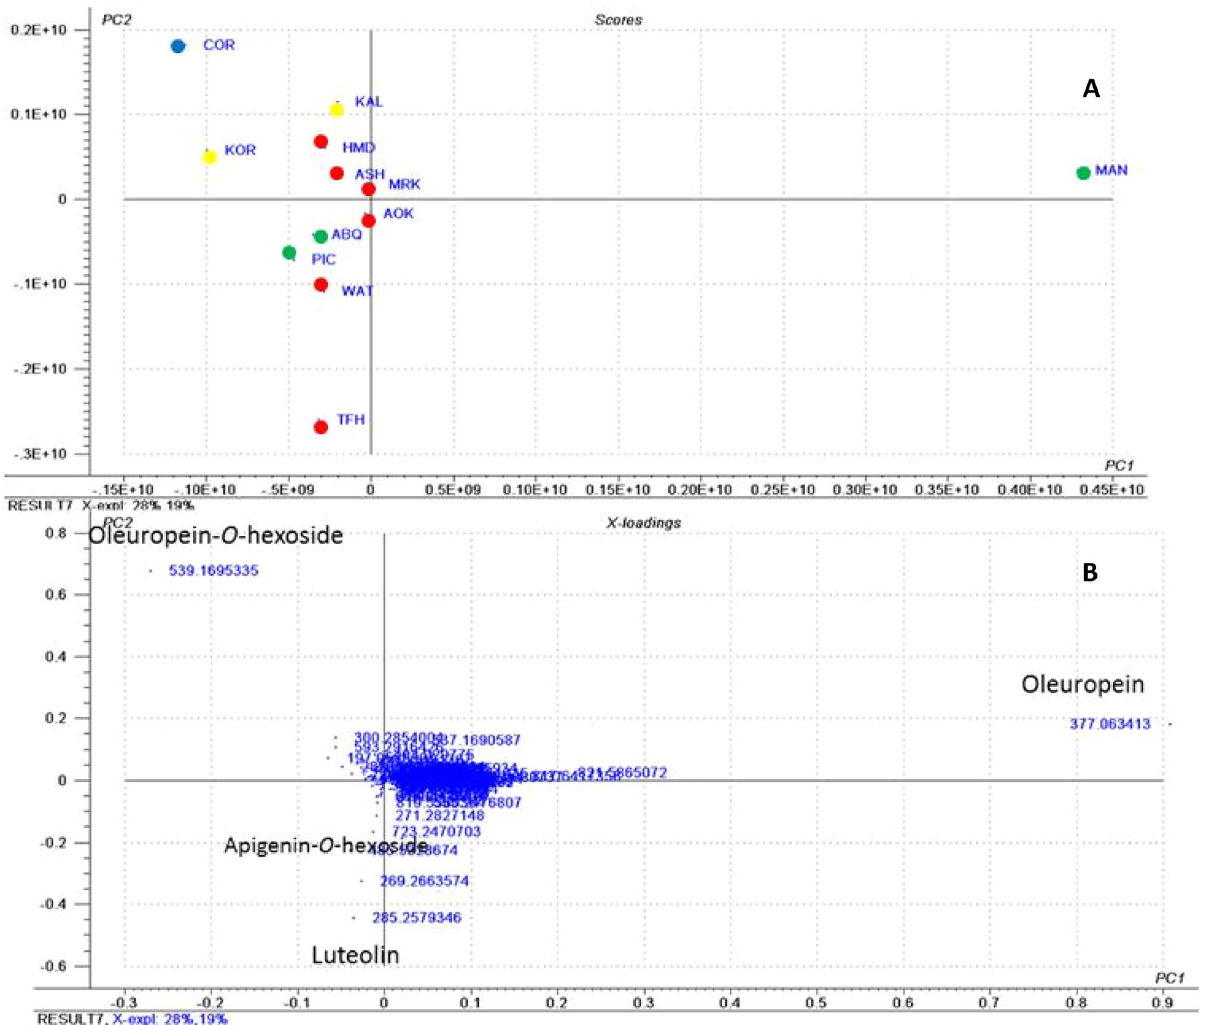
Figure 4. PCA analysis of different cultivars of olive leaves collected in spring derived from the negative ionization mode HPLC/MS data (m/z 100–1000); showing ( A ) a PCA score plot of metabolites of olive leaves and ( B ) a loading plot of metabolites of olive leaves. AOK Agizi Okasi, ASH Agizi Shami, HMD Hamed, MRK Maraki, TFH Toffahi, WAT Watiken, MAN Manzanillo, PIC Picual, ABQ Arbequina, KAL Kalamata, KOR Koroneiki, COR Coratina. Where, Egyptian cultivars in red, Spanish cultivars in green, Greek cultivars in blue and Italian cultivars in